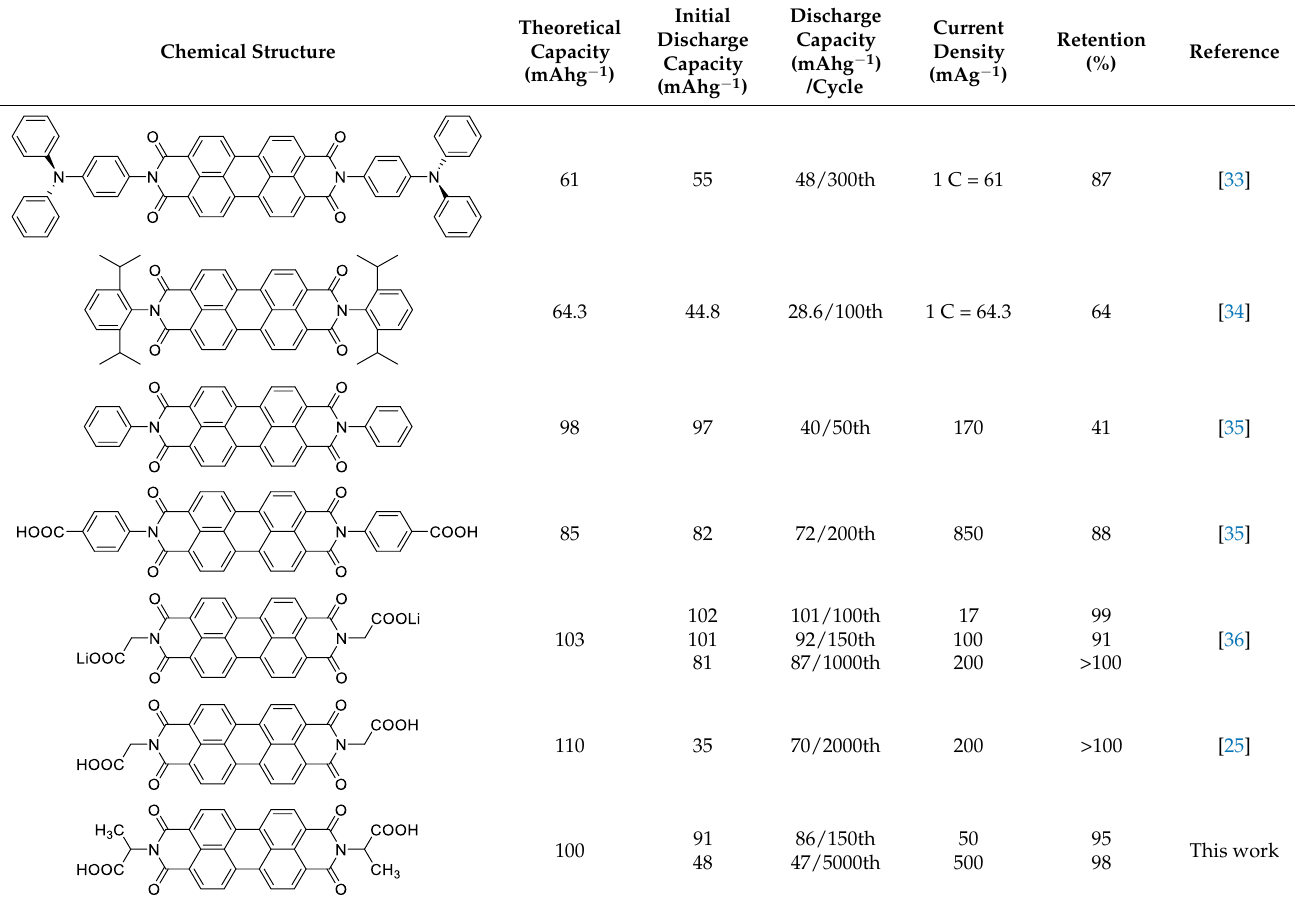
Table 2. Cycling performances of perylene-based single molecule as organic cathode for LIBs in recent work. Chemical Structure